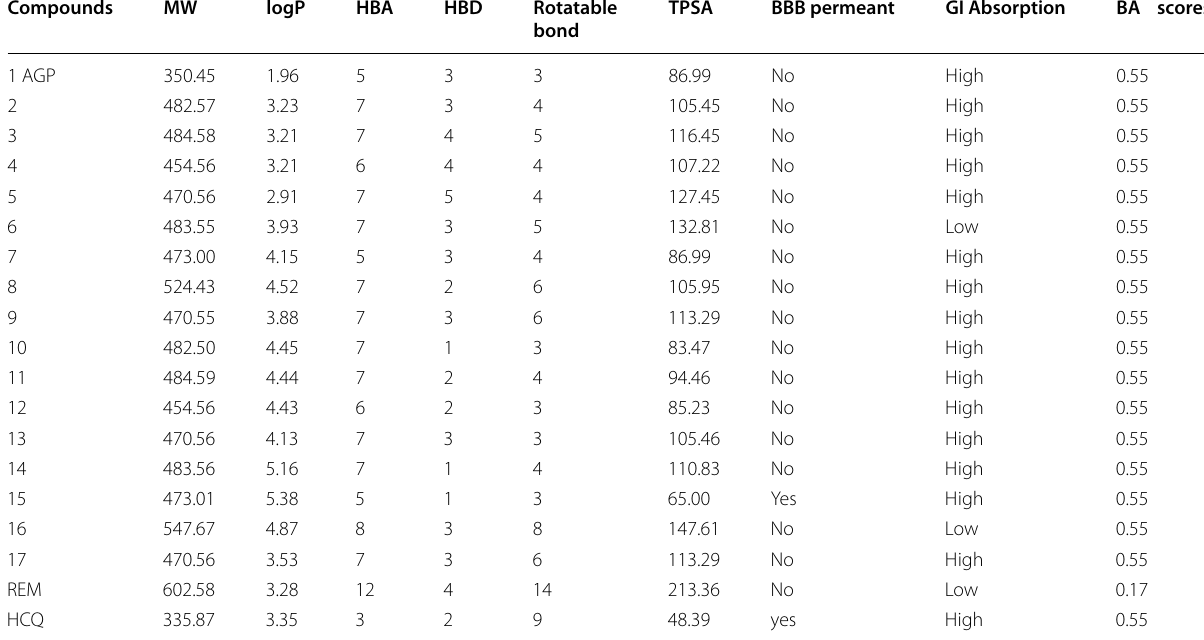
Table 1 Drug likeness and pharmacokinetic properties of AGP derivatives